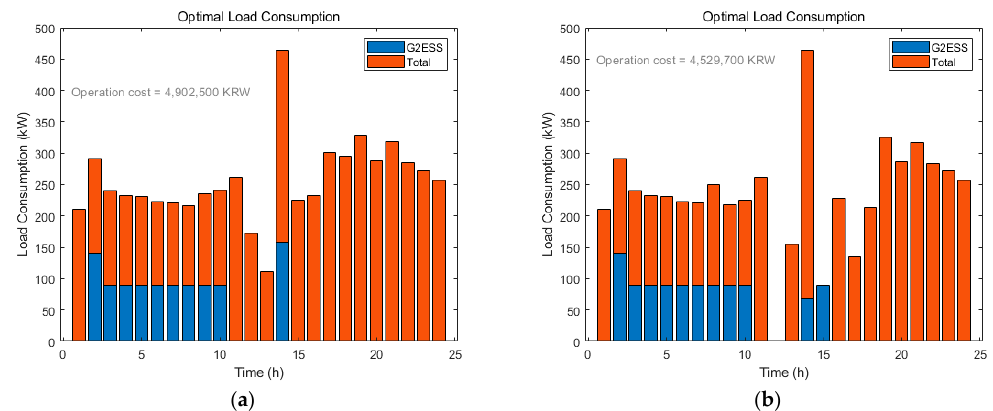
Table 2. Optimal operation cost comparison. Operation Cost without DR (KRW)